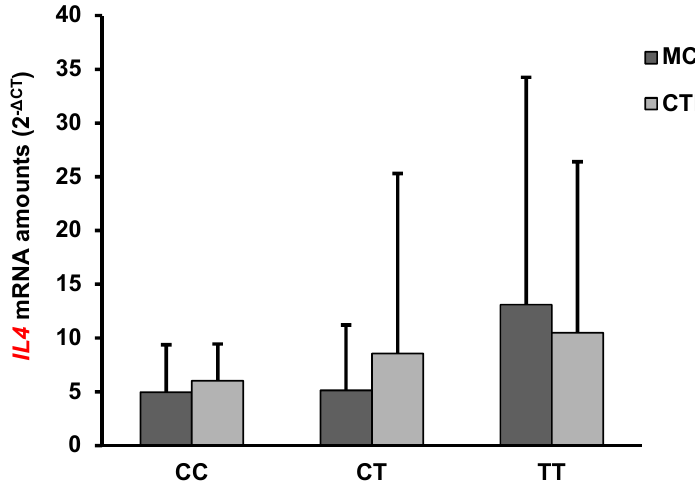
Figure 3. Mean IL4 mRNA expression levels in PBMC of MCS patients and healthy subjects (CTR) having different ADORA2A rs2298383 genotypes. Values shown are expressed as means ± SD. The assessment of secreted cytokine amounts showed that the mean IFN-γ serum concentrations were three-fold increased in MCS patients compared with healthy subjects (651.5 ± 441.9 vs 202.5 ± 19.14 pg/mL, p < 0.0001), while IL-4 concentrations were 1.5 fold-increased in MCS cases compared